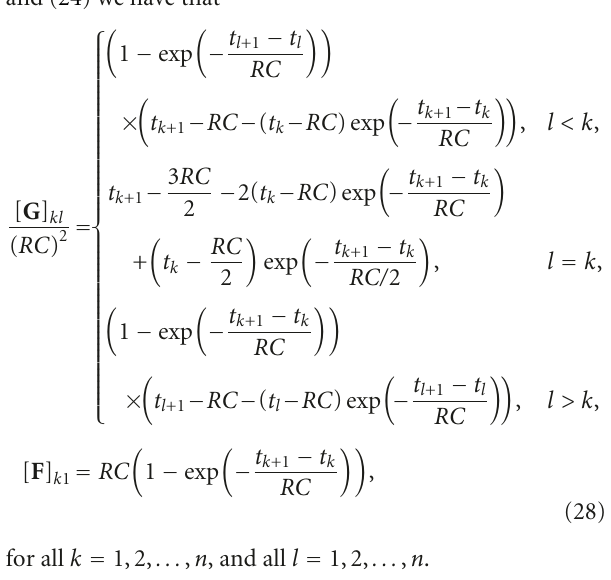
Algorithm 2. The minimizer (cid:18) u ∈ S 1 is given by (18)